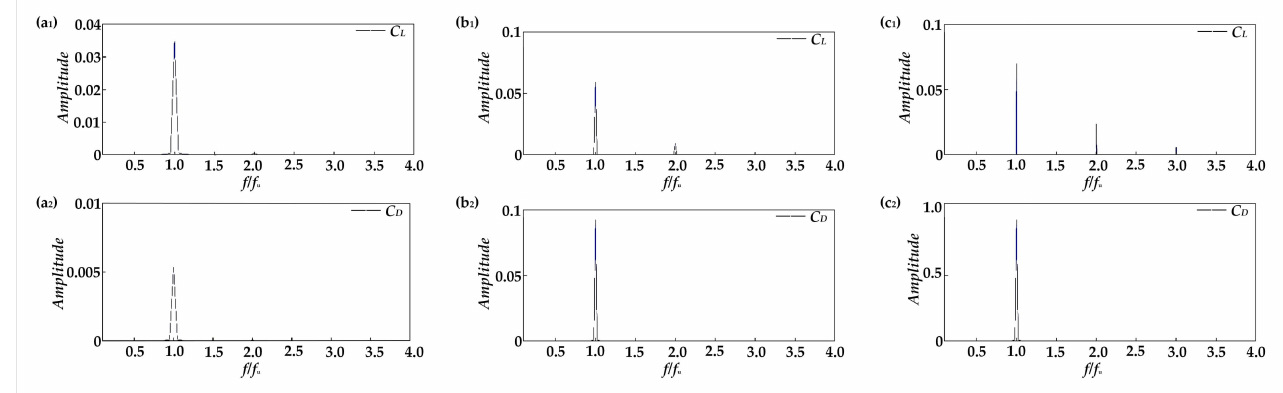
Figure 13. Spectrum of C L and C D in different sinusoidal oscillating flows: ( a 1 , a 2 ) U m = 0.5 m/s, f u = 1.39 Hz; ( b 1 , b 2 ) U m = 1.0 m/s, f u = 16.67 Hz; ( c 1 , c 2 ) U m = 2.0 m/s, f u = 66.67